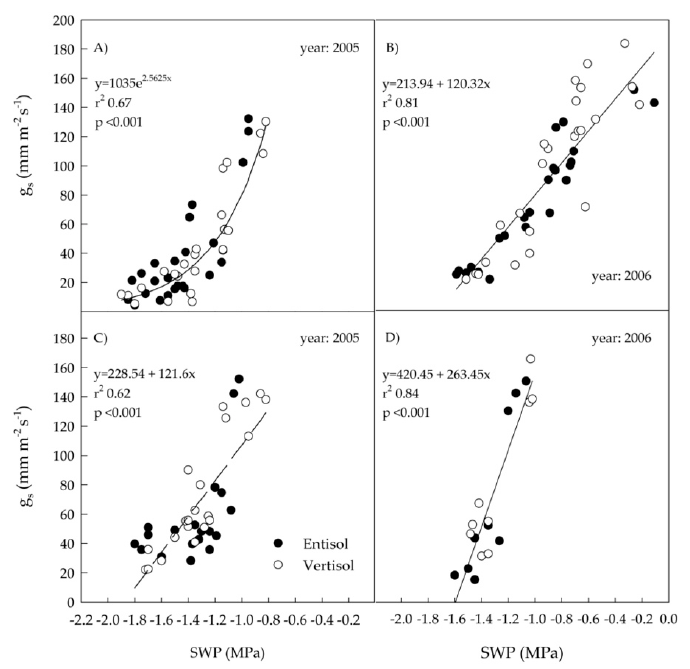
Figure 5. Relationships between stem water potential (SWP) and stomatal conductance (g s ) of ‘Nero d’Avola’ vines grown in two soils (entisol and vertisol) under rain-fed conditions in 2005 ( A ) and 2006 ( B ), and under regulated deficit irrigation (RDI) in 2005 ( C ) and 2006 ( D ). Each point is the mean of four measurements. Data from the two soil types were similar ( t -test of coefficients, p < 0.05) and pooled together for each year and irrigation treatment.